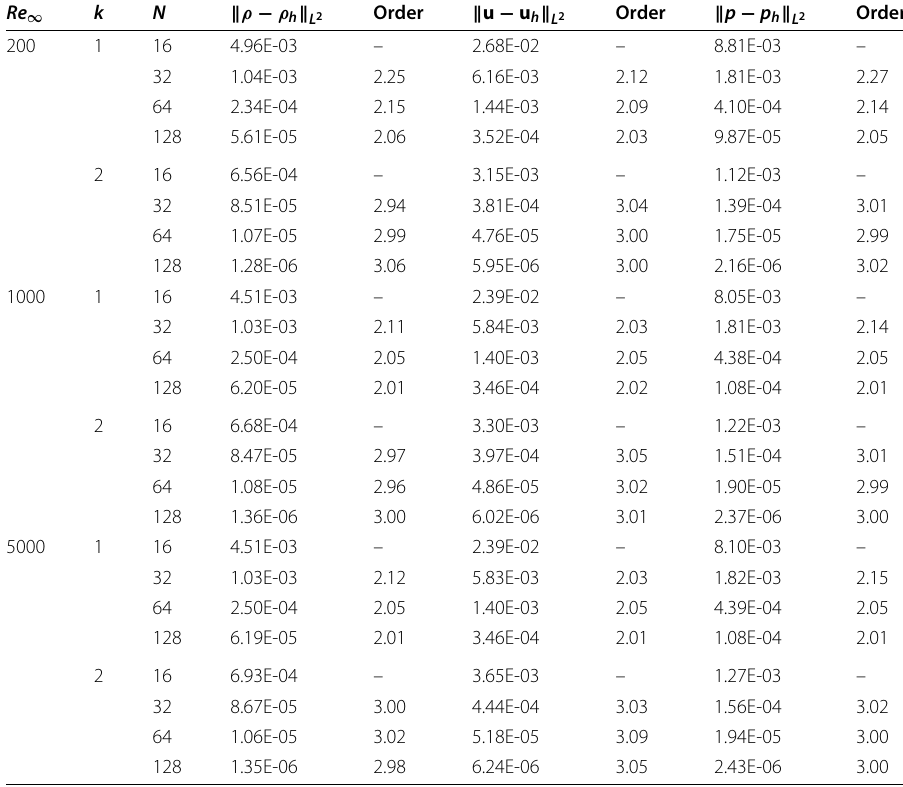
Table 2 Accuracy test for adaptive SDC-LDG scheme of 2D NS equations Re ∞